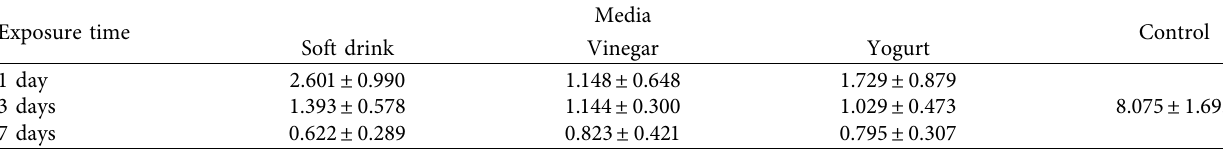
Figure 2: Curve-fitting analysis of the phosphate band (a) and amide I profile (b) of the IR dentin spectra illustrated the sub-bands. The experimental spectrum (black) is overlaid with the reconstructed envelope (red), which is composed of the fitted curves (green). Table 2: Mineral-to-matrix ratio (mean SD) in the dentin of tooth samples after exposure to the different media at variable times, including the control group. ±